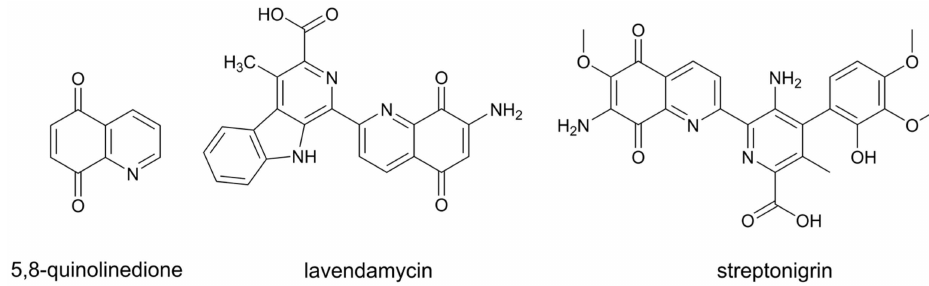
Figure 1. Structures of 5,8-quinolinedione and anticancer antibiotics containing this motif.